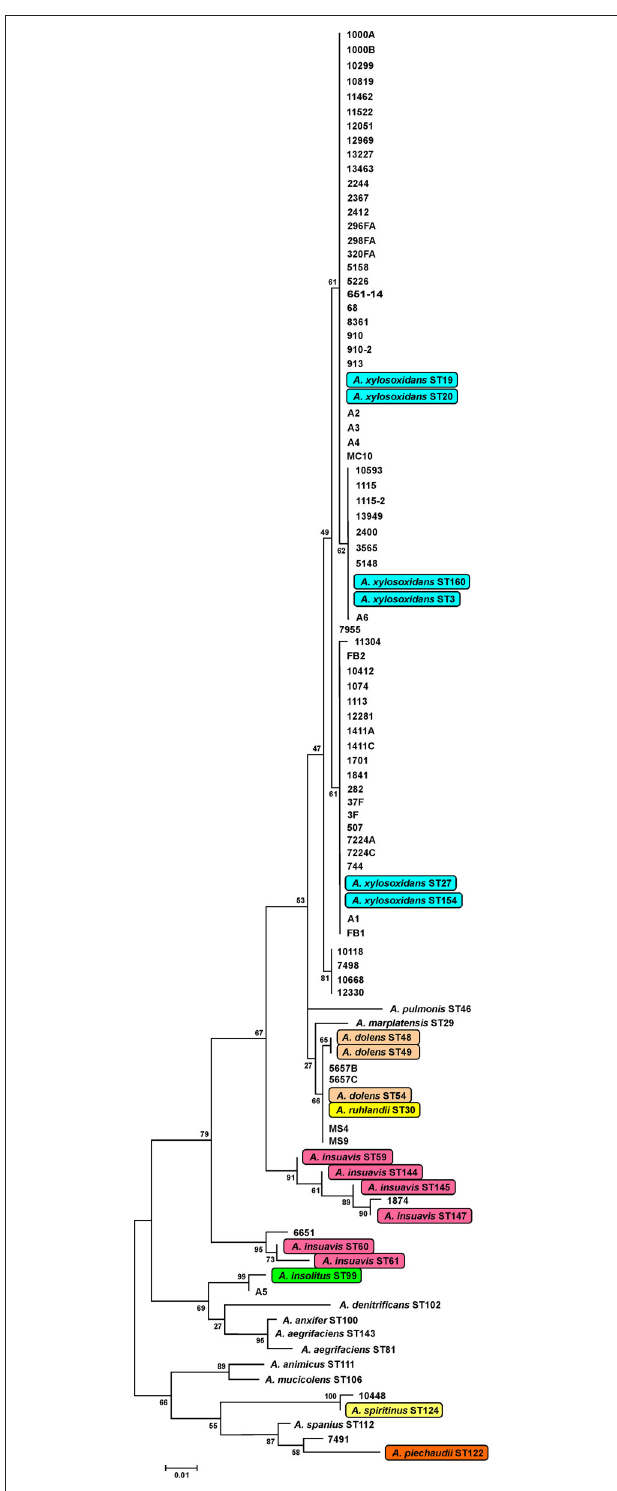
FIGURE 1 | Maximum-likelihood phylogenetic tree based on definite article the nrdA gene sequences (449 bp alignment) of Achromobacter type strains. Data for reference strains were derived from the pubMLST website (http://pubmlst.org/achromobacter/). Type strains of species represented amnong strains from the study are